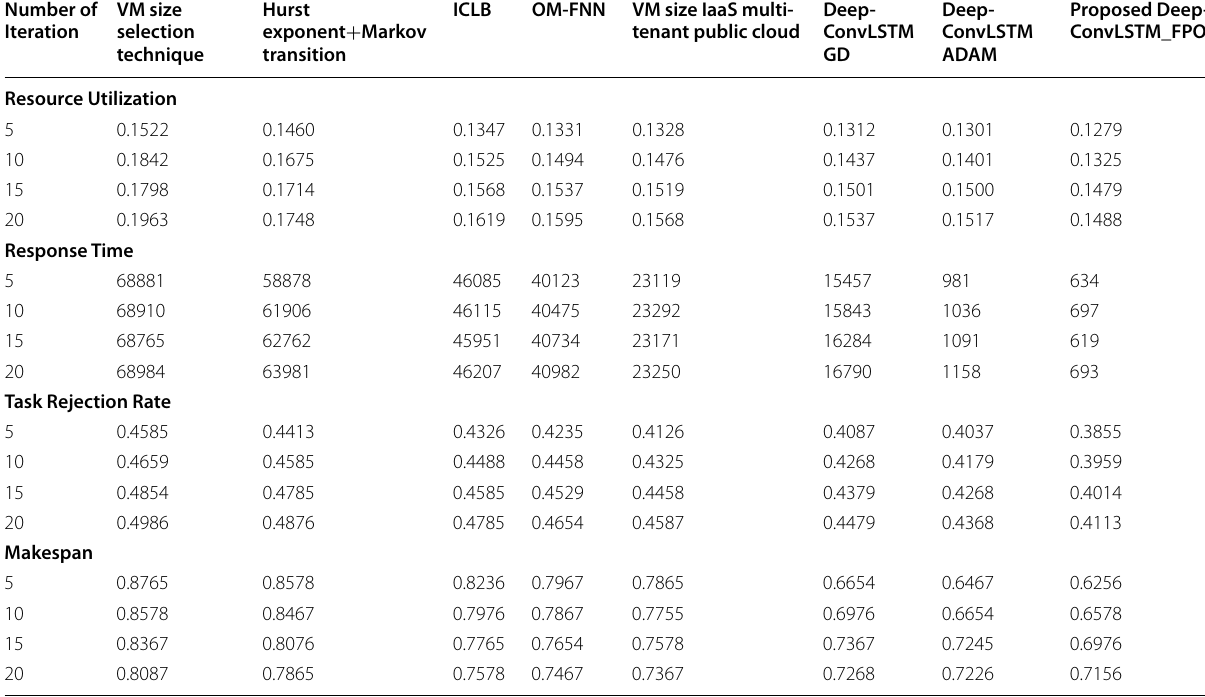
Table 9 Comparative Assessment of Deep-ConvLSTM_FPO Scheme With Task Size 400 Number of